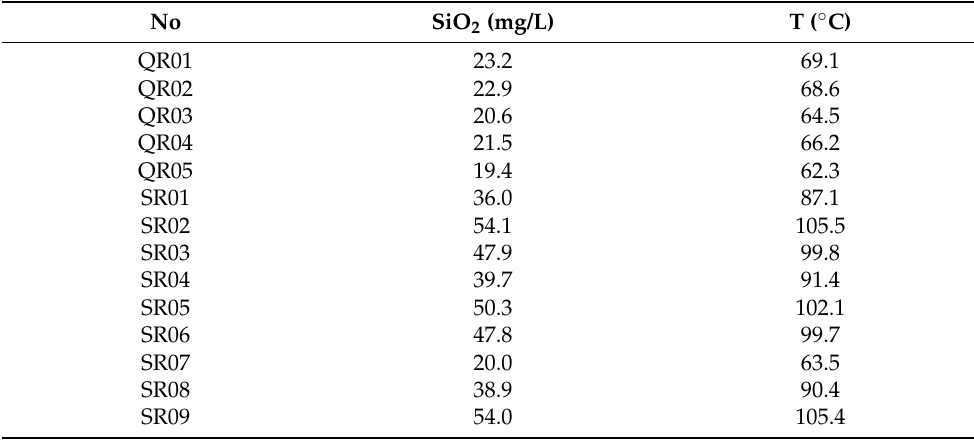
Table 3. Geothermal water storage temperature in the Rongcheng Bulge area.